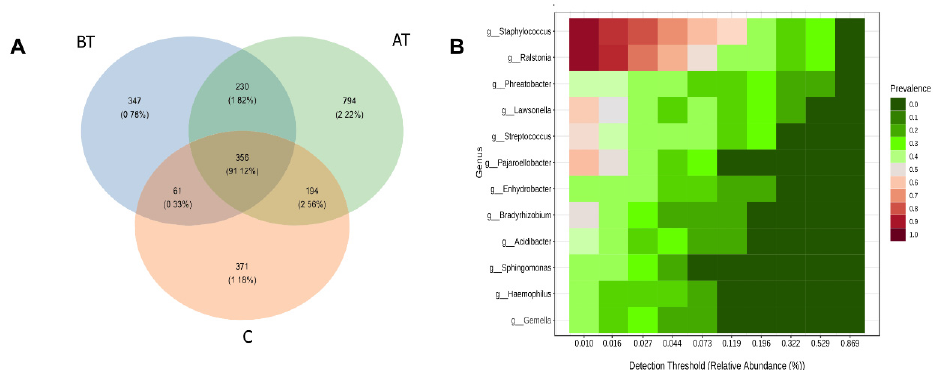
Figure 8. Core microbiota of the pre-treated (BT), treated (AT), and (C) acne groups. ( A ) presents the number and percent bacterial genera shared among the groups and unique to a certain group. ( B ) presents the percent of each genus in the core microbiota. The scale and color pattern are pro- vided in the figure.